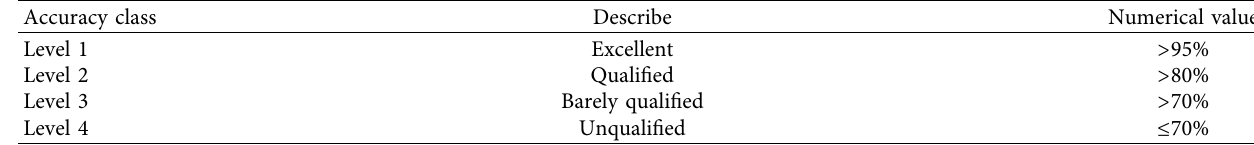
Table 4: Division of accuracy standards.